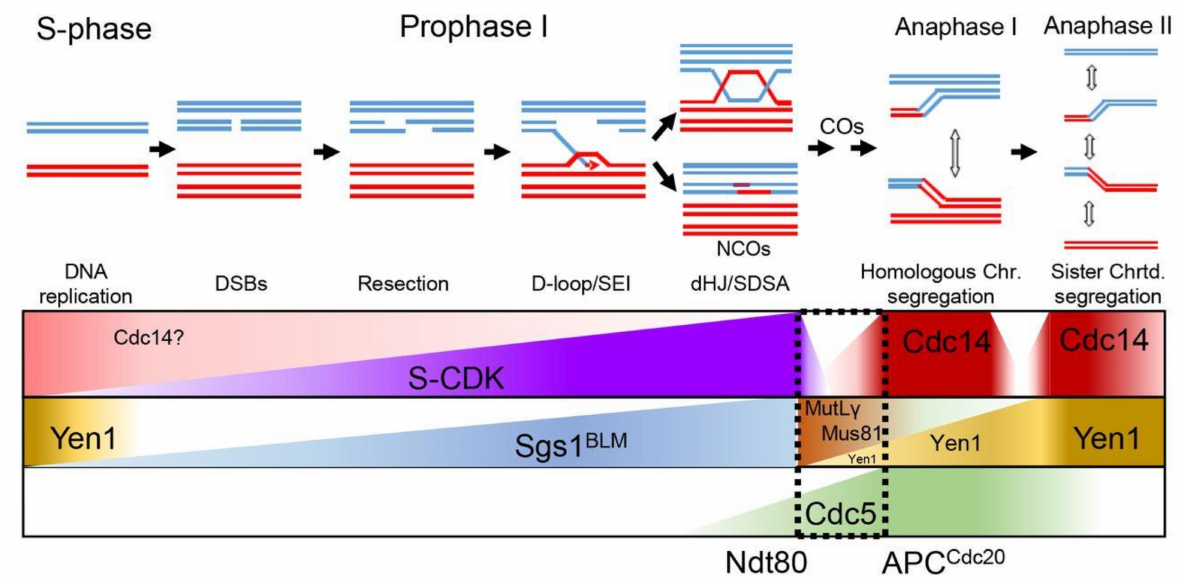
Figure 8. Model for CDC14 -dependent resolution of recombination intermediates via multiple mechanisms. Contribution of Cdc14 to the correct disjunction of recombining chromosomes during meiosis. Early in prophase I, chromosomes initiate homologous recombination. 3 (cid:48) -resected ssDNA overhangs invade an intact template with the help of recombinases. The displacement of the intact strand from the template allows for the formation of D-loops, which can be stabilized, allowing for DNA synthesis. Next, stabilized branched DNA molecules might be disrupted by the action of the anti-recombinases. Reannealing of the extended 3 (cid:48) -ssDNA overhang with the resected complementary strand, followed by further DNA synthesis will lead to the repair and ligation of the broken DNA duplex, giving rise to NCOs via SDSA. ZMM stabilization of JMs is followed by the resolution of dHJs through the MutL γ , class I, dedicated CO pathway. Ndt80-dependent expression, and activation, of Cdc5 triggers MutL γ resolvase activity. Unresolved linkages between bivalents that persist until metaphase/anaphase I are mostly resolved by the action of the SSEs, Mus81-Mms4. Slx1-Slx4, Top3-Rmi1 as well as Cdc14/Yen1 also contribute to the correct resolution of chromosomal entanglements between homologs during MI. Residual chromatid intertwining between sister chromatids during the second meiotic division will be removed by the action of Cdc14/Yen1. Gradual implementation of Yen1 activity during both divisions by Cdc14 will transfer Yen1 inactive population to its active/nuclear-enriched